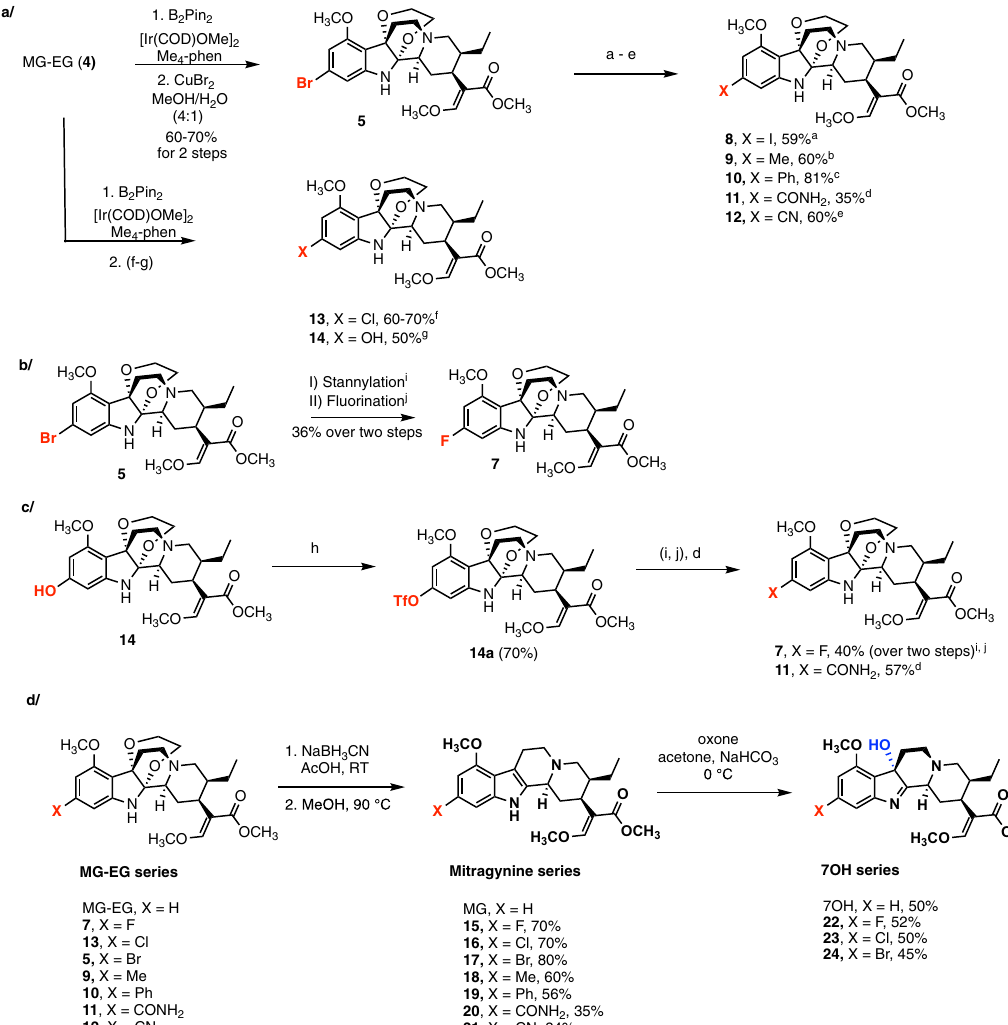
Fig. 5 The MG-EG scaffold is compatible with a wide array of functionalization chemistries. a , b , c Synthesis of C11-substituted analogs of MG-EG. (a) NaI, CuI, N , N ’ -dimethylethylenediamine, 110 °C, 46 h. (b) Pd 2 (dba) 3 , XPhos, DABAL-Me 3 , THF, 60 °C, 2 h. (c) Pd(dppf)Cl 2 ·CH 2 Cl 2 , PhB(OH) 2 , CsOAc, THF, 70 °C, 7 h. (d) Pd(OAc) 2 , dppf, Co 2 (CO) 8 , DIPEA, NH 4 Cl, imidazole, dioxane, 90 °C, 15 h. (e) Pd 2 (dba) 3 , Zn dust, Zn(CN) 2 , [HPtBu 3 ]BF 4 , DMF, RT, 3 h. (f) CuCl 2 ·2H 2 O, MeOH: H 2 O (4:1), 80 °C, 12 h. (g) H 2 O 2 , THF, 0 °C to RT, 30 min. (h) PhNTf 2 , DIPEA, DMF, 50 °C, overnight. (i) ( n Bu 3 Sn) 2 , Pd(PPh 3 ) 4 , LiCl, dioxane, 100 ° C, overnight. (j) AgOTf, F-TEDA-PF 6 , RT, 20 min. The yields are based on >2 repetitions. d Reductive removal of ethylene glycol. This step renders 11-substituted MG analogs, which in turn can be oxidized to the corresponding 7OH derivatives. The yields are average based on at least 3